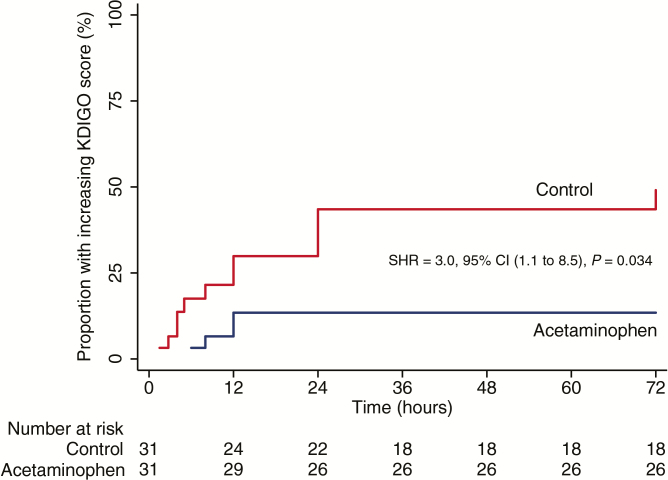
Kaplan–Meier plot comparing in-hospital acute kidney injury (AKI) development in patients with severe and moderately severe malaria treated with either acetaminophen or no acetaminophen (control). Patients were classified as developing AKI if they had a creatinine rise of ≥26.5 µmol/L after admission. A total of 17/62 (27%) patients had AKI during admission: 12/17 (38%) in the control group and 5/12 (16%) in the acetaminophen group. Competing risks regression adjusted by study site was used to assess subdistribution hazard ratio. Patients were censored at the time of creatinine rise meeting Kidney Disease: Improving Global Outcomes criteria and death censored as a competing risk preventing the primary event of interest (AKI) from occurring. Abbreviations: CI, confidence interval; KDIGO, Kidney Disease: Improving Global Outcomes; SHR, subdistribution hazard ratio.